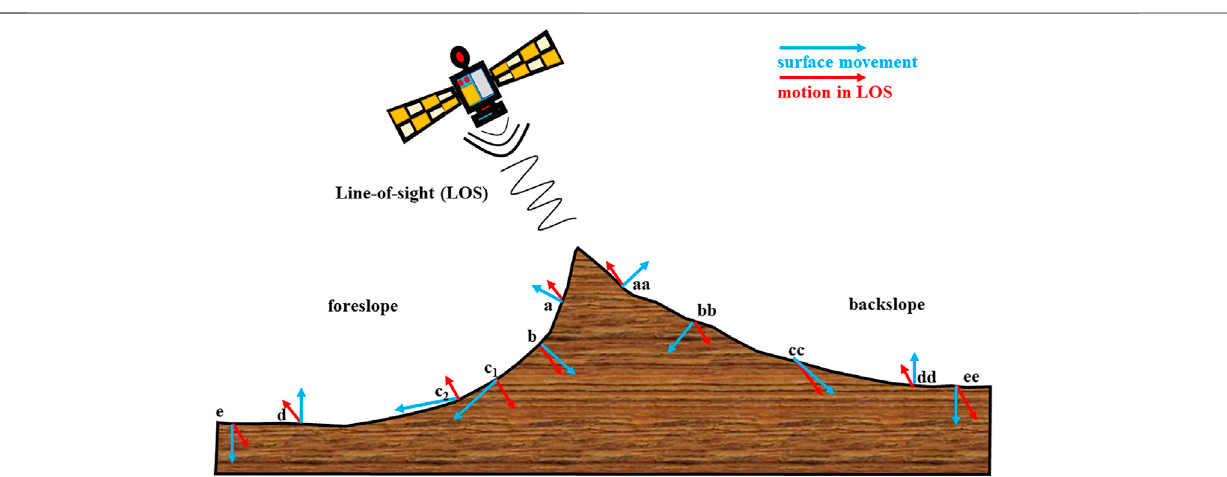
FIGURE 8 | The relationship between surface movements and InSAR detected displacements in LOS direction, particularly for mountainous regions, derived from literature (Chen et al., 2013).